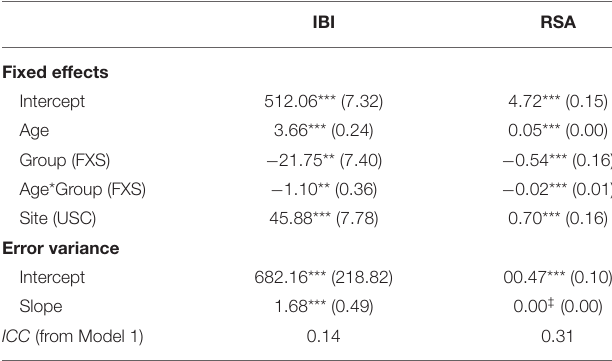
TABLE 3 | Estimates for Hierarchical Linear Models of IBI and RSA across early development. IBI RSA Full multivariate general linear model results are outlined in Table 4 . IBI intercept was a marginally significant predictor in the overall model, F (2,48) = 2.78, p = 0.072. The main effect of group was significant, F (2,48) = 4.28, p = 0.019. Tests of